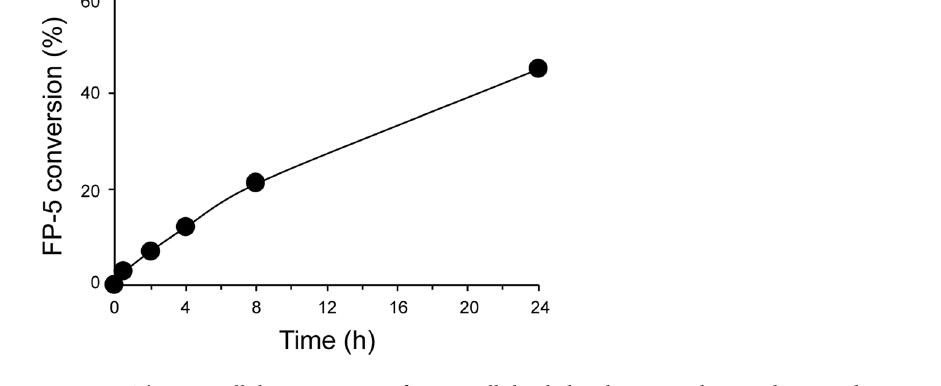
Figure 2. The intracellular conversion of FP-5. Cells loaded with FP-5 probe were harvested at various time points (0.5–24 h) and cellular extracts were subjected to MS analysis. The original acetylated form of FP-5 was gradually converted to hydroxyl-derivative as demonstrated by percentage of conversion during